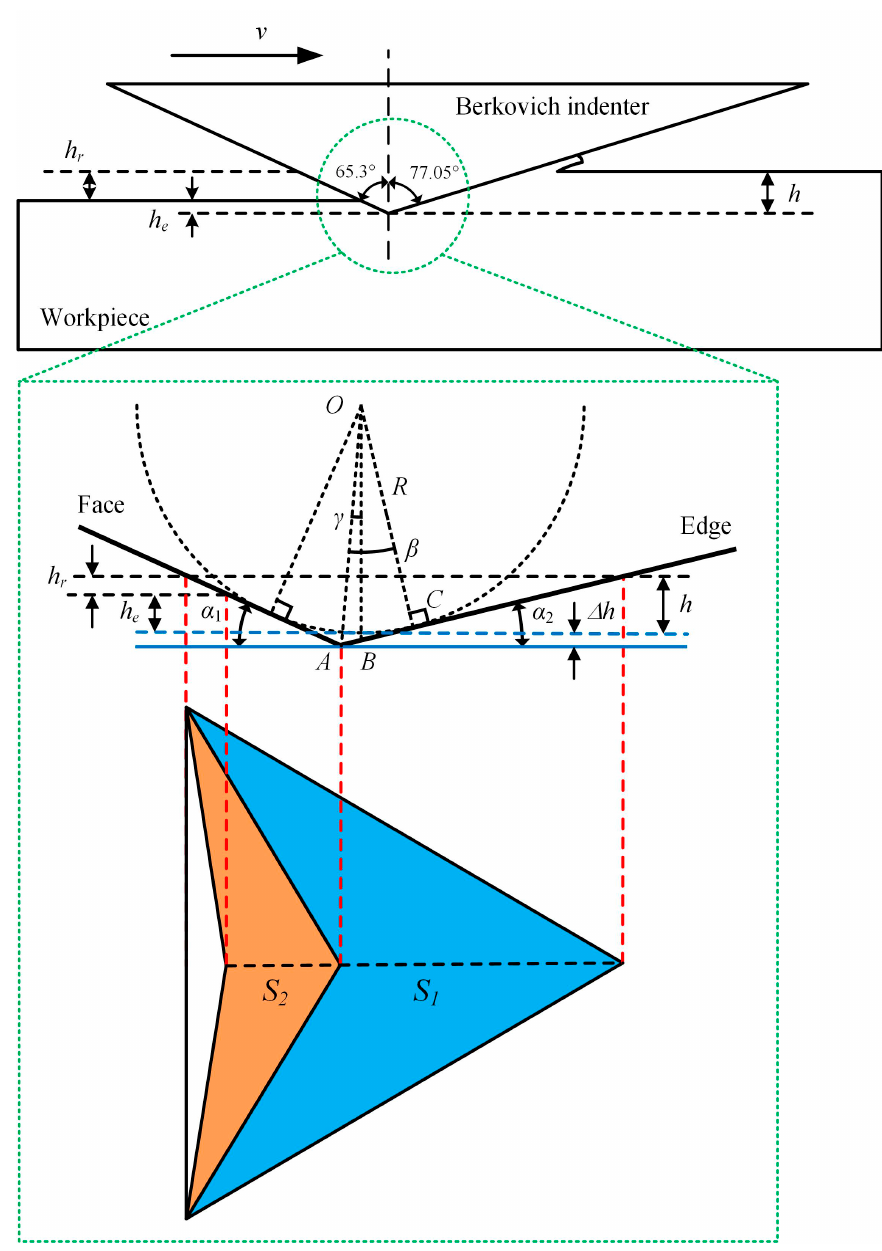
Figure 9. The projection contact area between the Berkovich indenter and the workpiece.